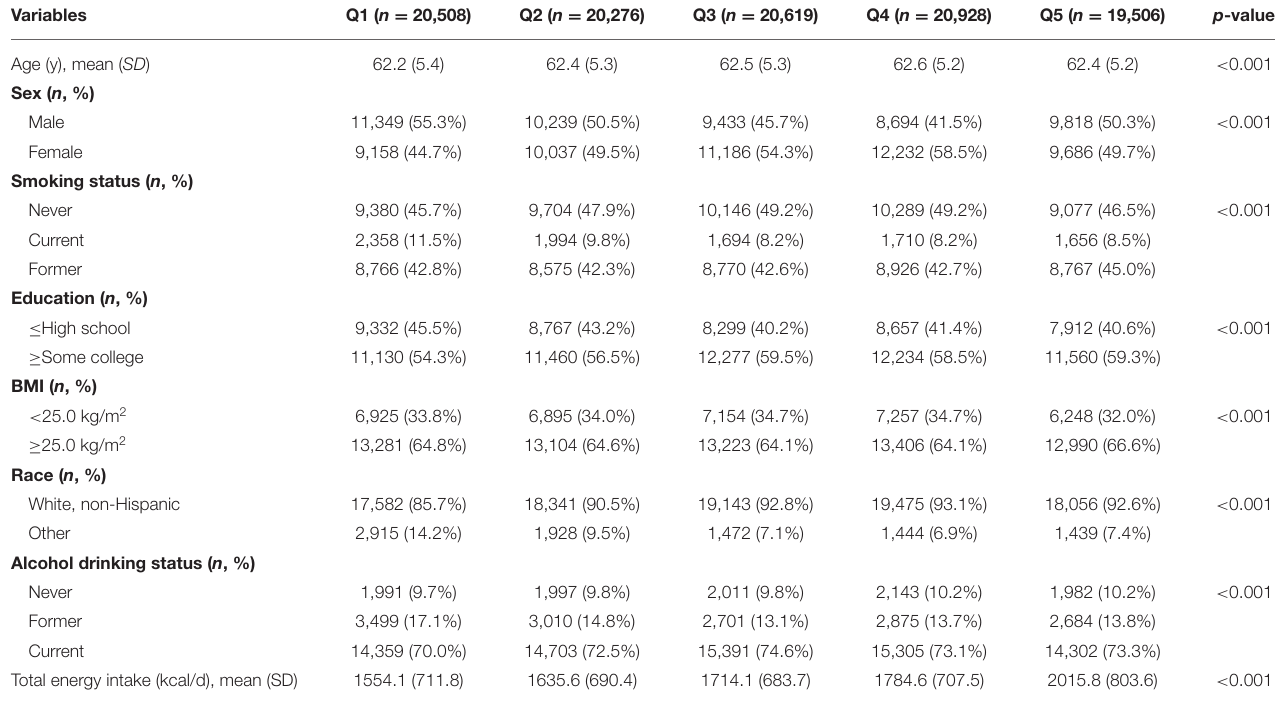
TABLE 1 | Main characteristic of participants included in this study by raw tomato intake.